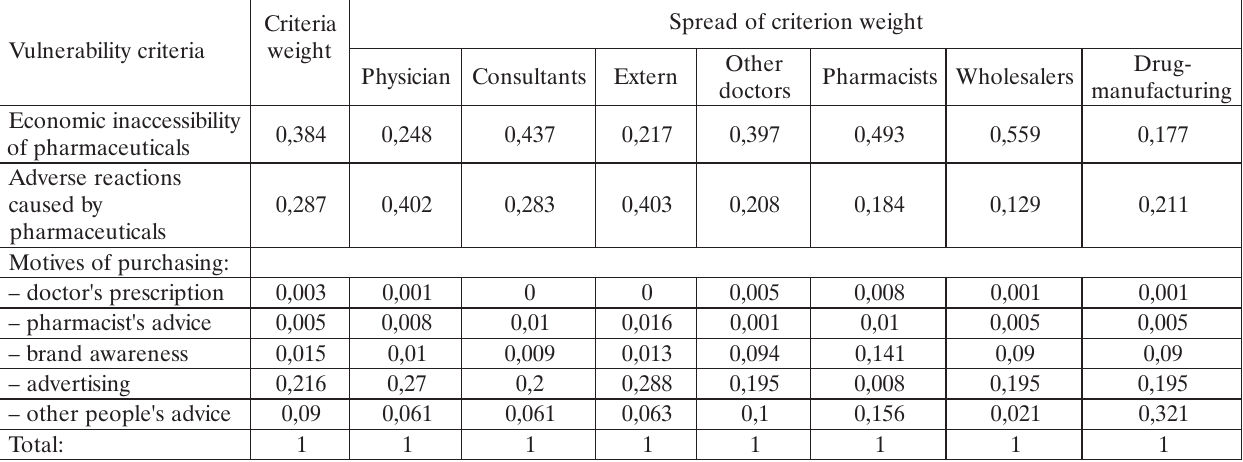
Table 1. Pharmaceutical consumer vulnerability criteria and their